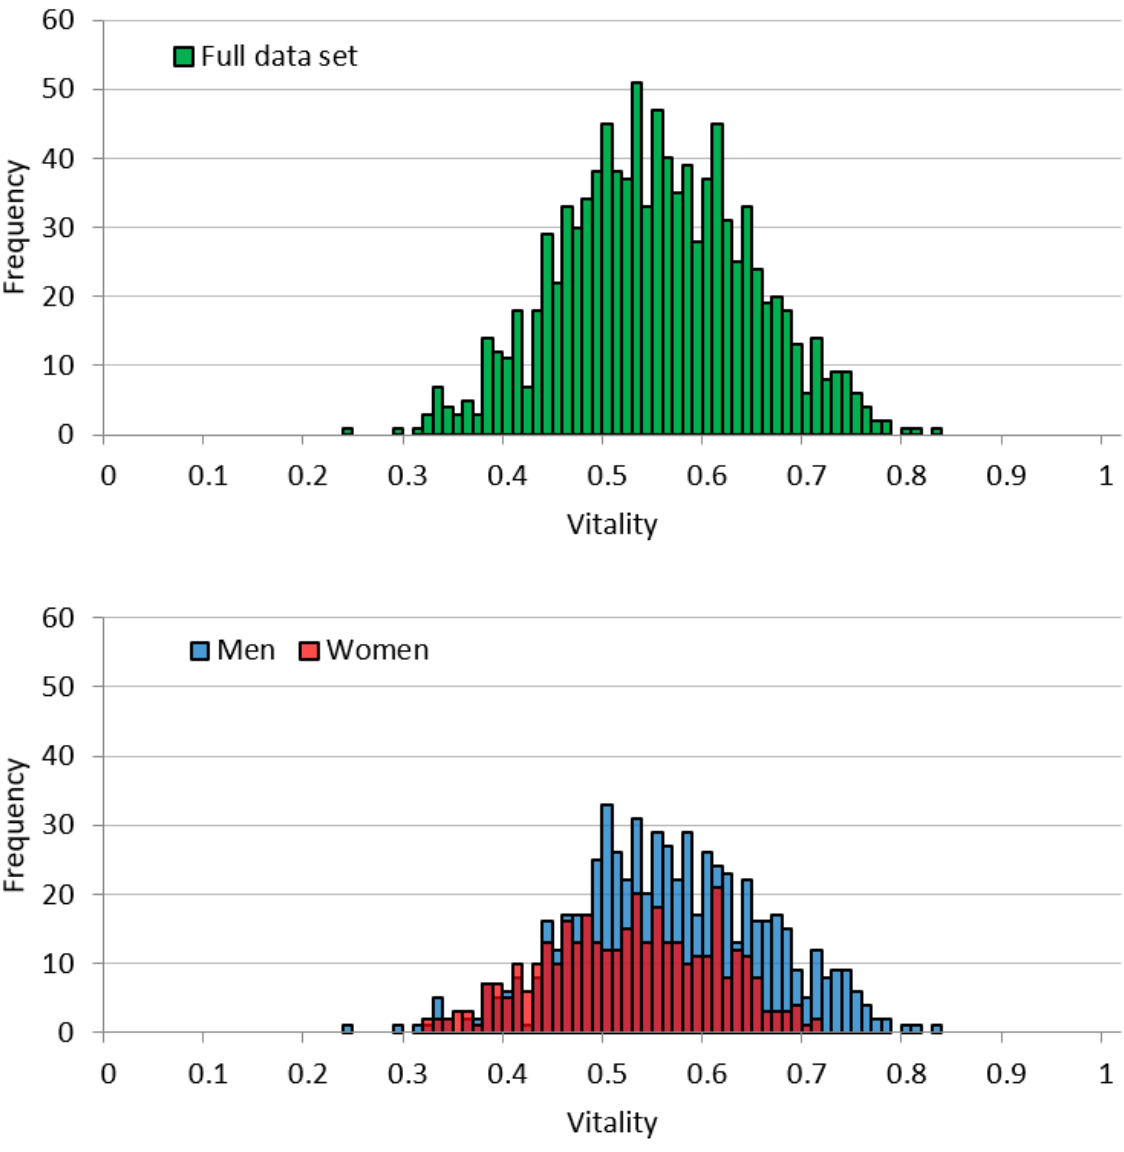
Figure 3. User dataset vitality distribution for the full set and by